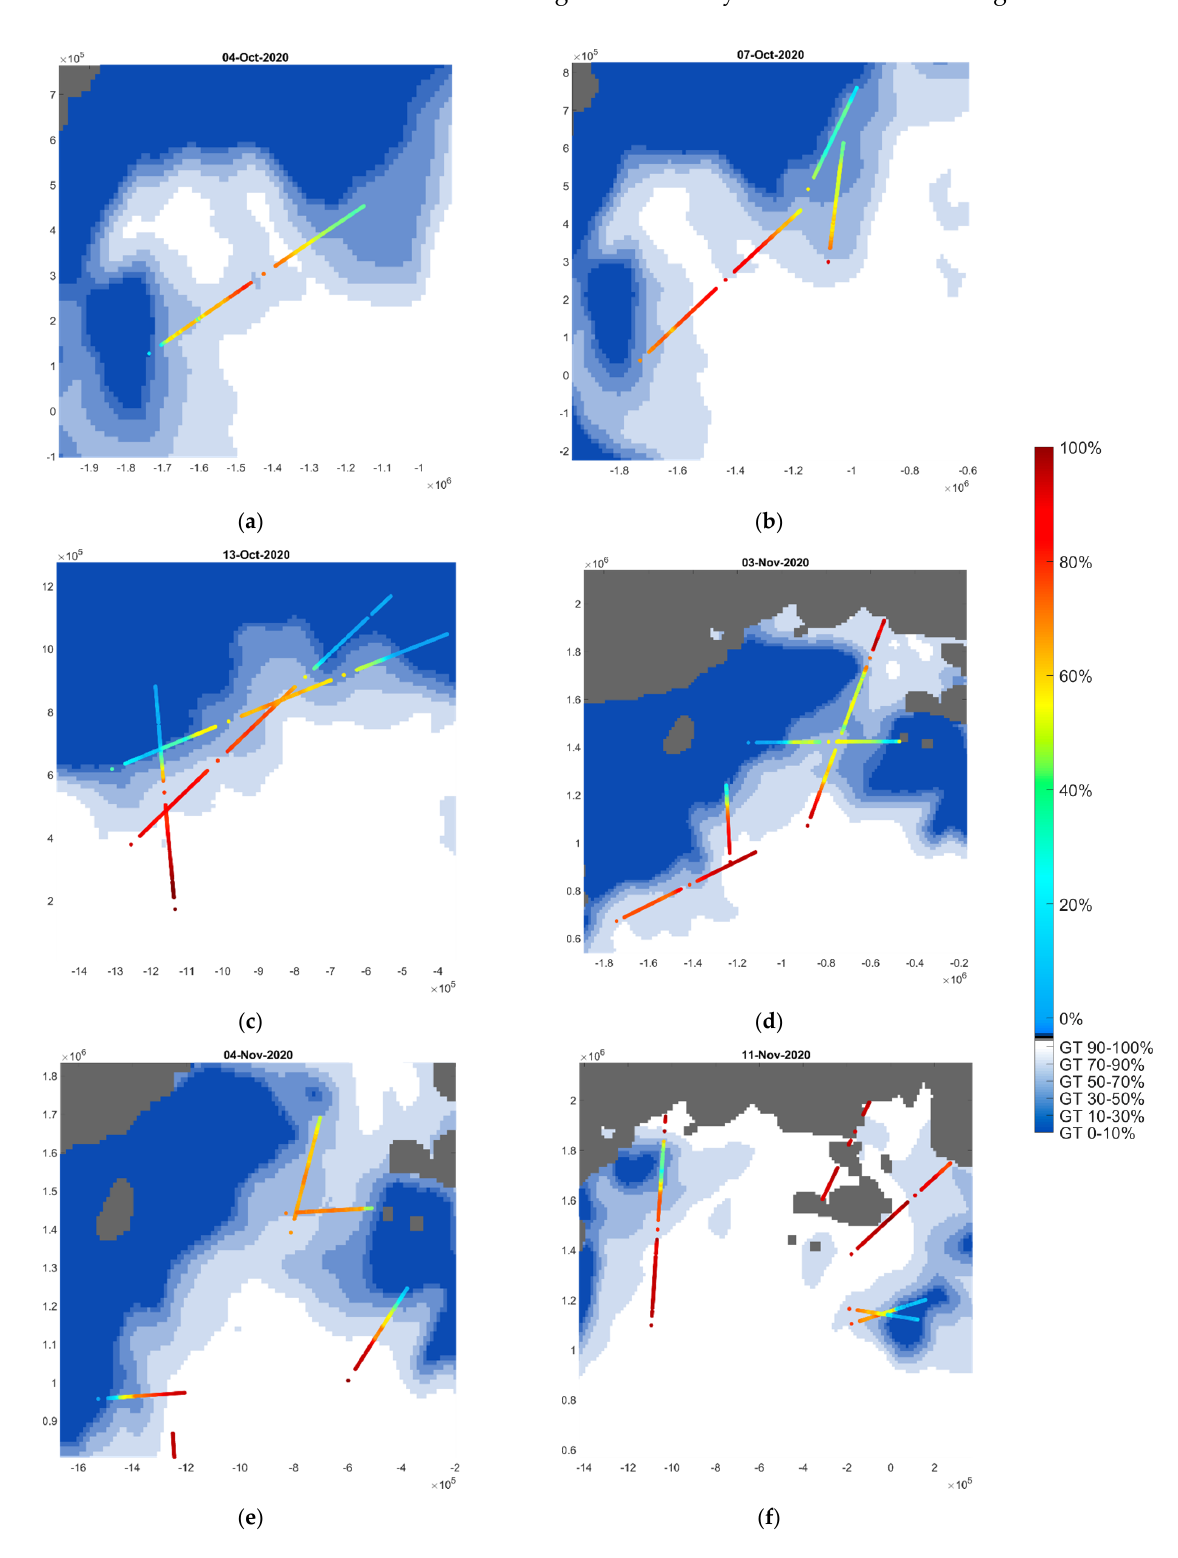
Figure 17. SIC GNSS-R comparison with OSI SAF: ( a ) 4 October, ( b ) 7 October, ( c ) 13 October, ( d ) 3 November, ( e ) 4 November, and ( f ) 11 November.